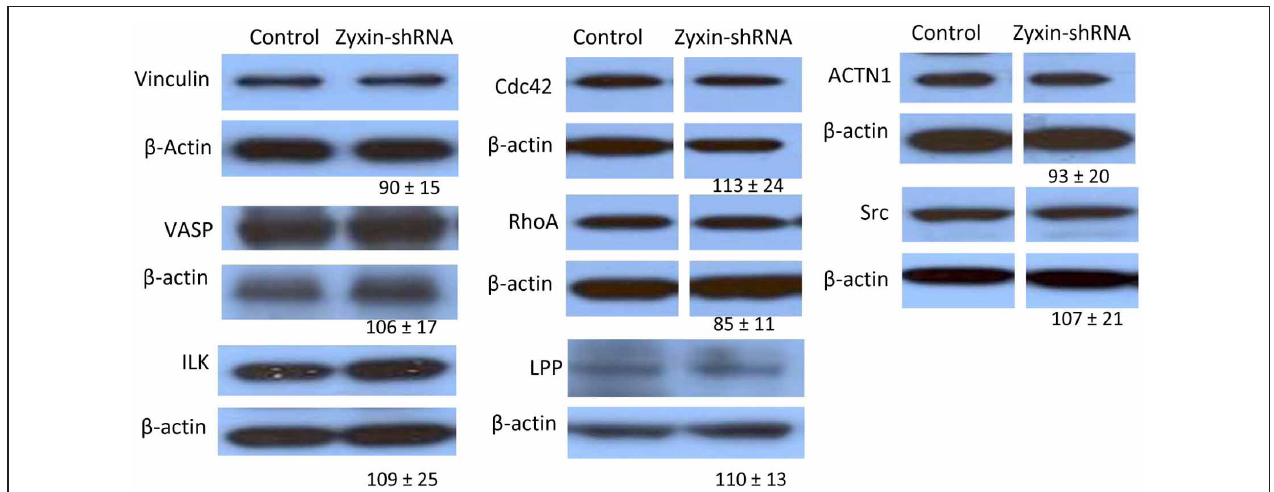
FIGURE 7 | Western blot results showing that zyxin silencing did not significantly affect the expression of a number of focal adhesion proteins: Vinculin, VASP, Actinin 1,Cdc42, c-Src, RhoA, ILK, and LPP, as compared between cells stably expressing zyxin-shRNA and cells